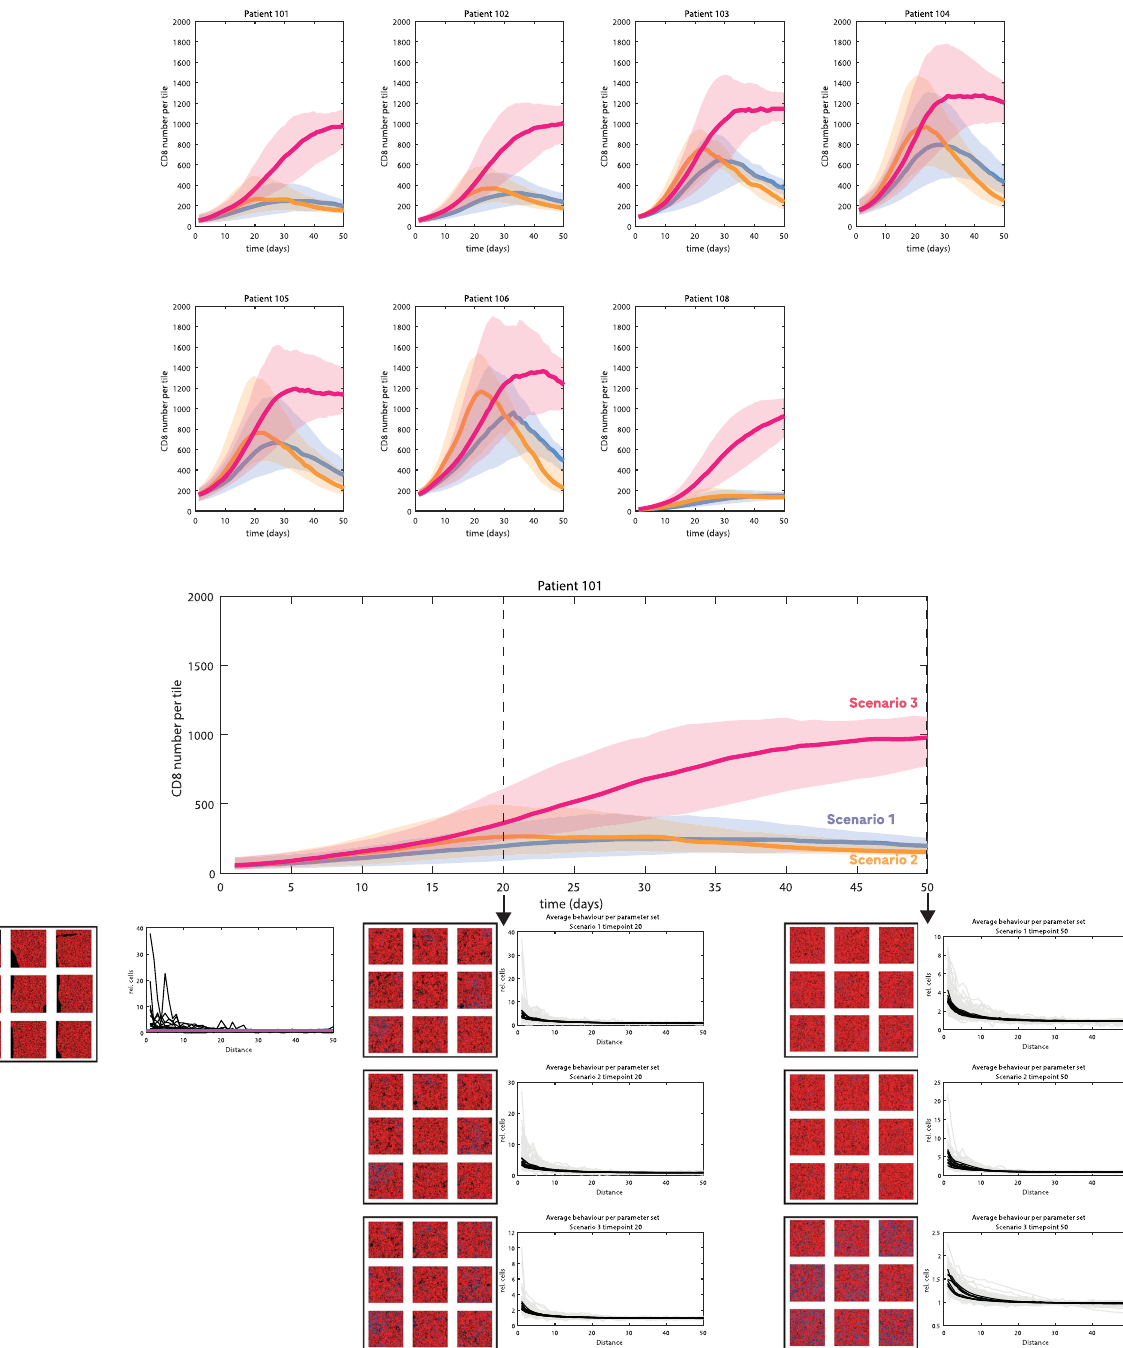
Fig. 6 Use of model predictions for clinical trials. a Simulations of the CD8 time course for Simlukafusp monotherapy (scenario 1, shown in blue) and two hypothetical combination treatments. The orange line (scenario 2) represents a treatment that would increase the proliferation rate of CD8 cells by two times and the red line (scenario 3) represents a treatment that would increase the in fl ux rate of CD8 cells into the tumour by eight times. Shaded regions correspond to the 50% quantiles from simulations with the population parameters. b A full illustration of how the model can be used to inform clinical planning for one example patient from the test set. At each time point, the spatial distribution summary of immune cells, as well as simulated biopsy images, can be extracted, and these can inform drug development teams. In the spatial summary statistics, all simulations are shown in grey and the black lines are the average spatial statistics for each parameter set across all tiles and stochastic repeats. In the simulated biopsy images, red represents tumour cells, blue represents immune cells and black indicates non- tumour